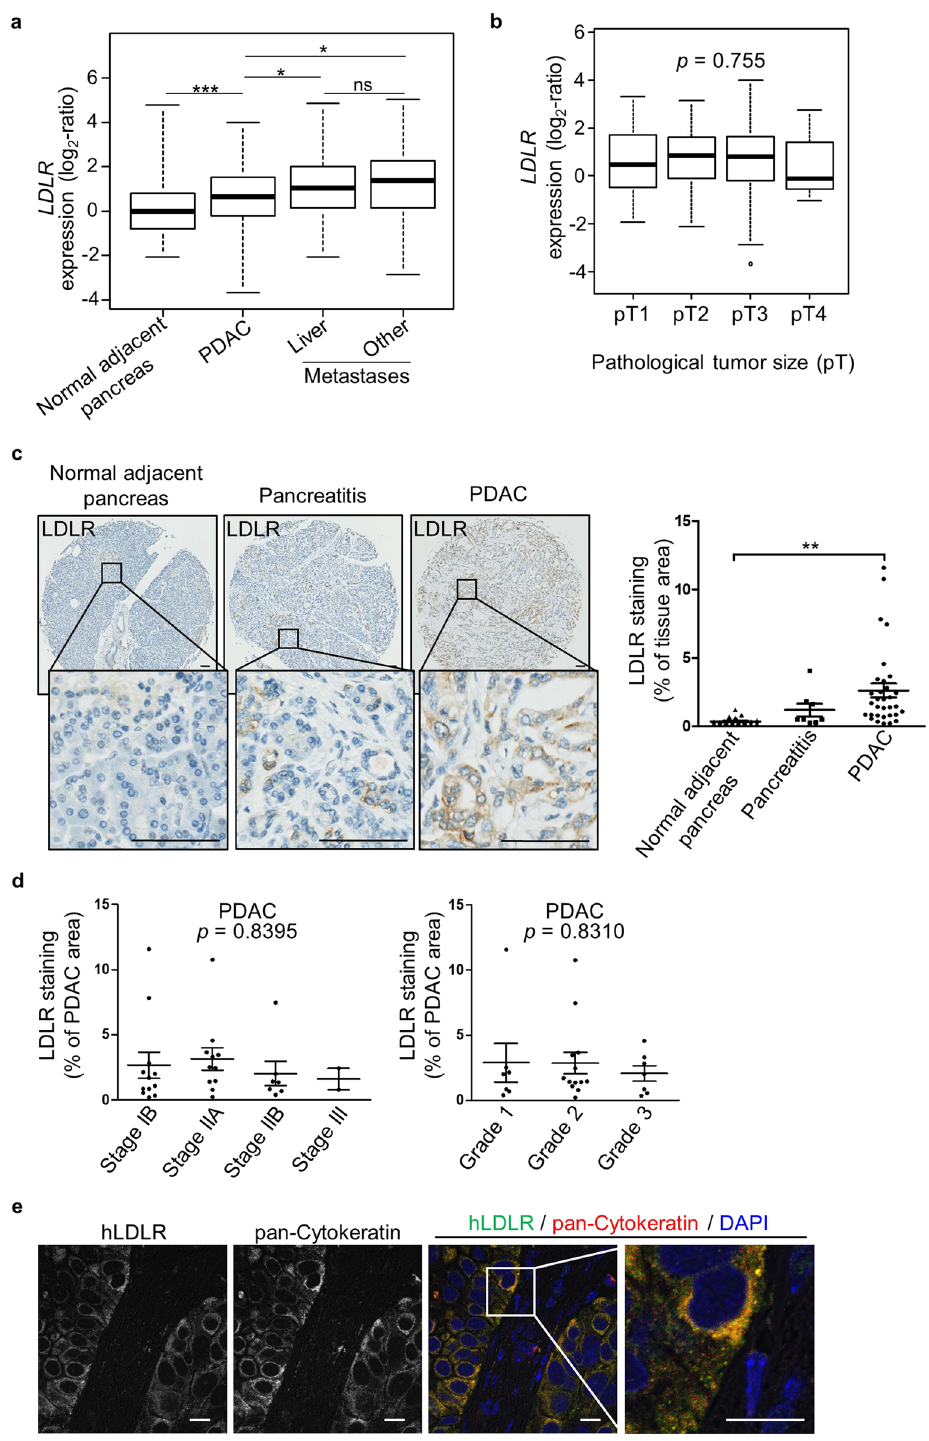
VH4127 peptide, bearing non-natural amino acid residues, and which speci fi cally binds to rodent and human epidermal growth factor (EGF) homology domain of LDLR (Supplementary Table S2). To prolong its exposure time to its target, the VH4127 peptide was conjugated via a polyethylene glycol spacer, containing 6 ethylene glycol units, to the C-terminus of dimeric Myc-tagged Fc fusion protein (Fig. 3a) 17 . The resulting bivalent Fc-VH4127 was fi nally covalently labeled with the Alexa Fluor 680 dye (A680) (i.e., Fc(A680)-